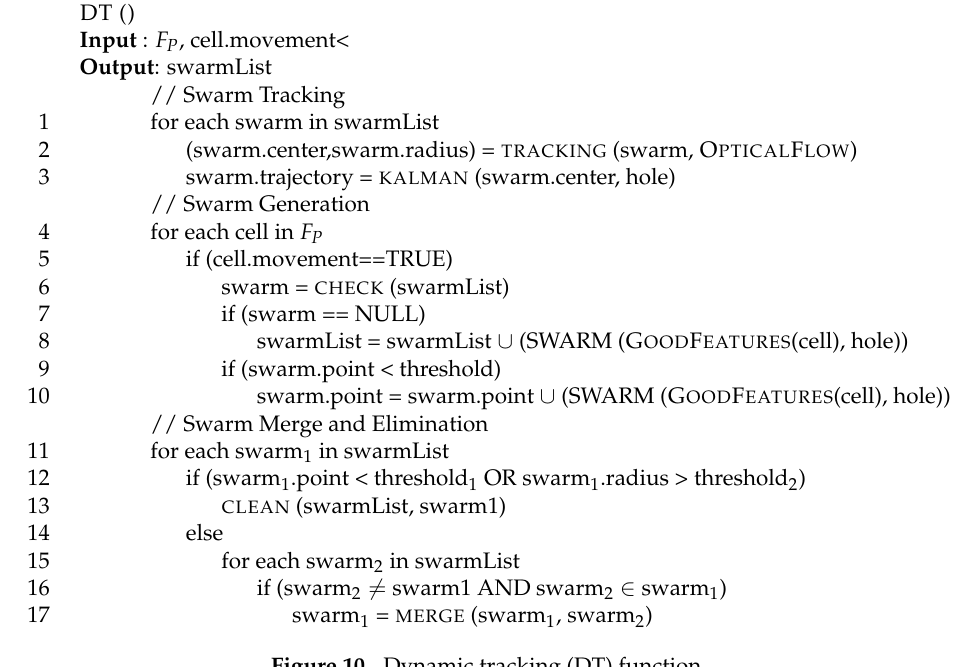
Figure 10. Dynamic tracking (DT)